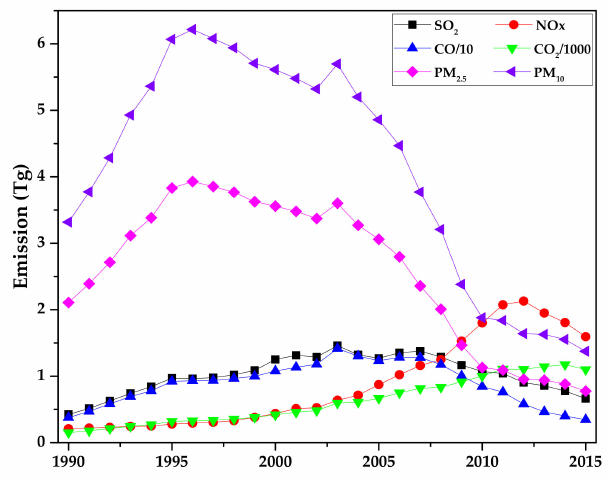
Figure 4. Air pollution emissions trend from China’s cement industry for the period 1990–2015 (data taken from